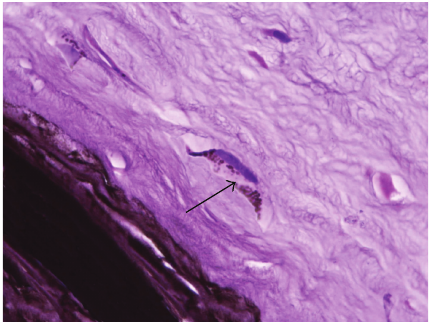
Figure 10: A photomicrograph of rabbit cornea group II, showing stromal cells which have pigment granules inside their cytoplasm (arrow). H&E ×